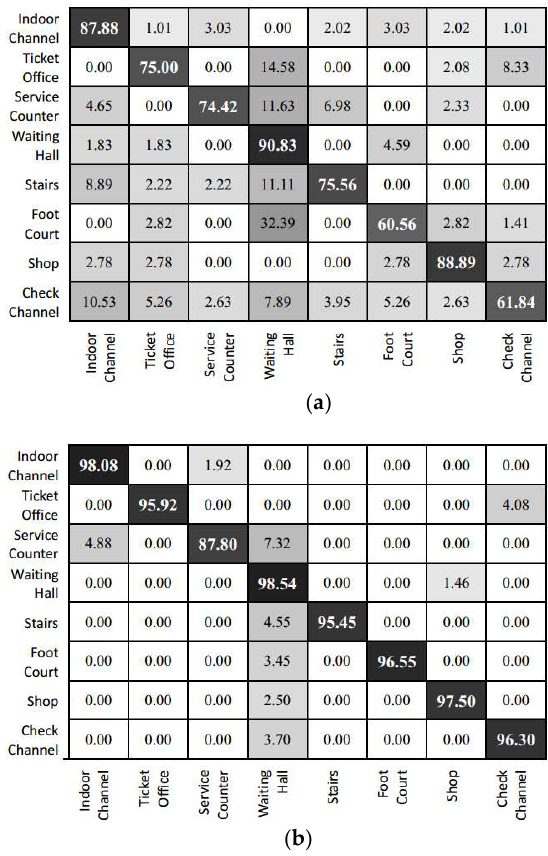
Figure 14. Confusion matrix of the prediction result in railway station. ( a ) Inception V3; ( b ) the feature fusion model.